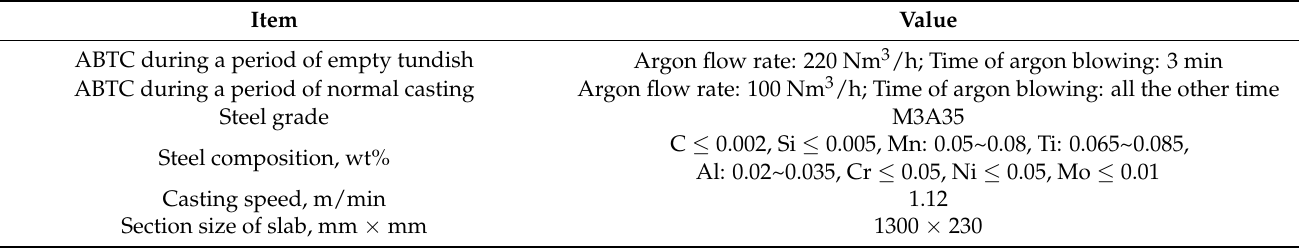
Table 4. Process parameters of argon blowing tundish cover and continuous casting.